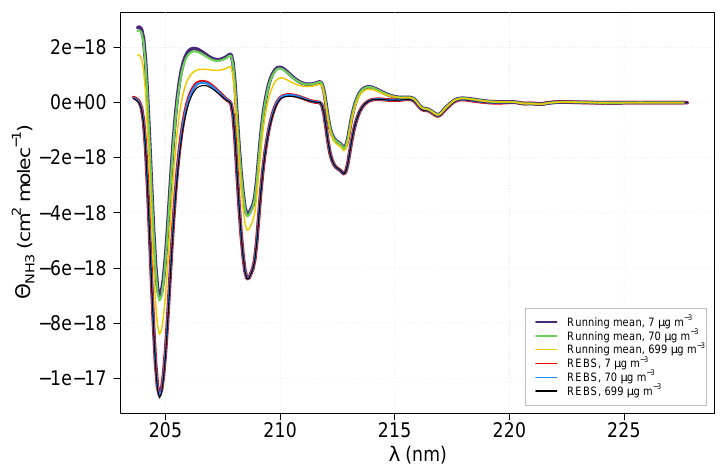
Figure 3. (cid:50) NH derived from simulated I adj with absorption from ˆ c i = 7, 70 and 699µg NH 3 m − 3 over L path = 75m; two types of high-pass 3 filters are investigated: one based on a running mean over a 27-pixel window ( ≈ 7.7% of investigated wavelength range, similar to Volten et al., 2012) and one based on our REBS